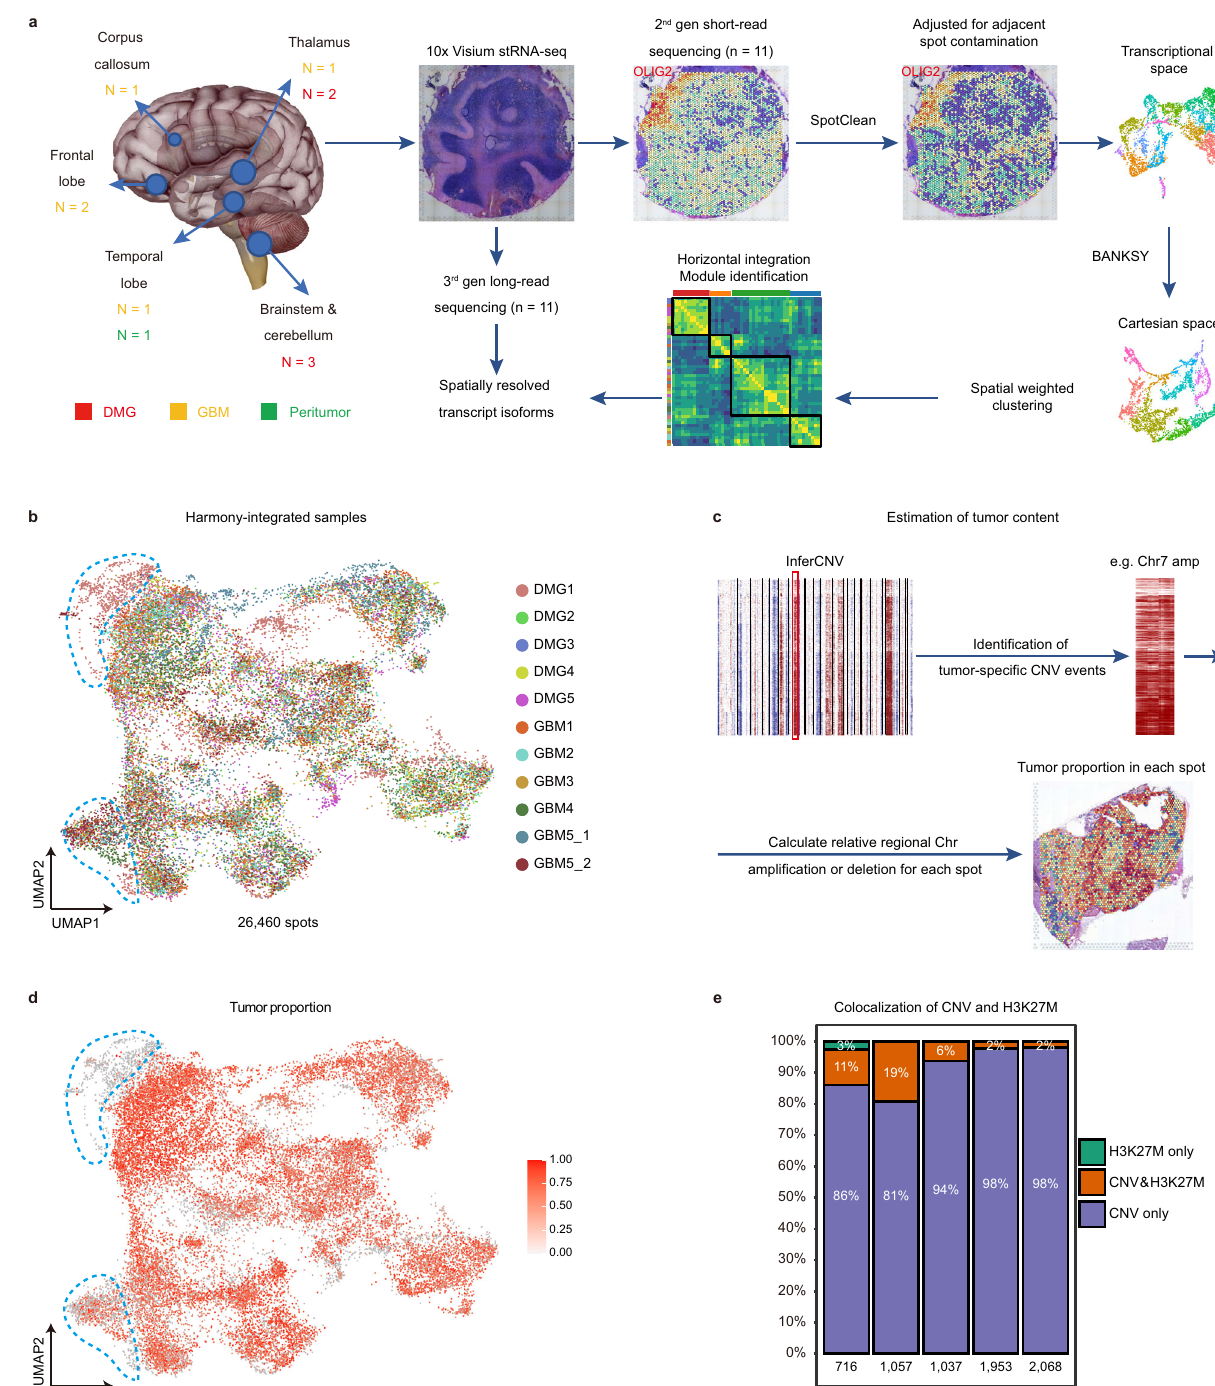
Fig.1|Overviewofwork fl owandsampleinformation.a Illustrationoftheoverall work fl ow. Examples images for SpotClean-adjusted gene expression ( OLIG2 ) and BANKSY-based spatial clustering for DMG1 are shown. b UMAP of all Harmony- integrated spatial transcriptomic spots ( n =26, 460) from all samples ( n =11). Colors represent different samples. Clustersof peritumor spots are highlightedby blue dashed lines. c Overview of the work fl ow for CNV-based estimation of tumor